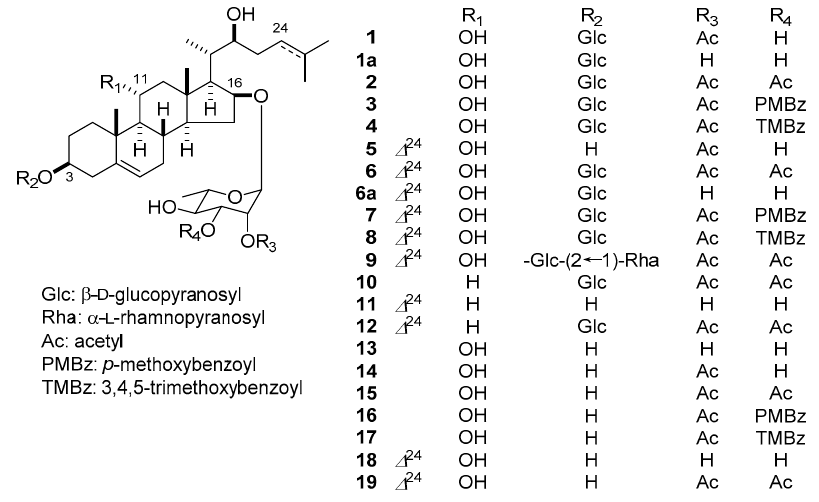
Figure 1. Structures of 1 – 19 , 1a , and 6a .